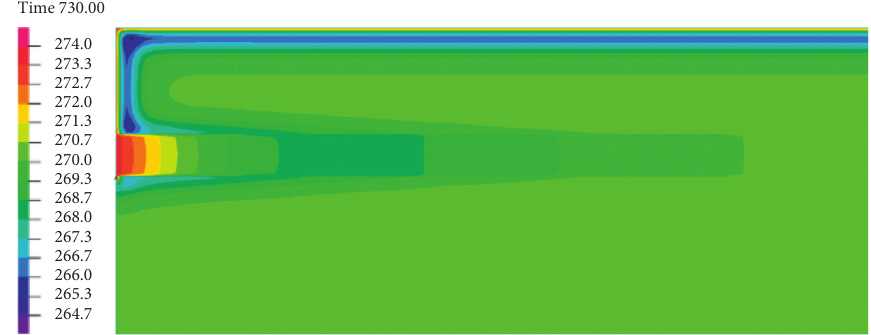
Figure 12: Average temperature distribution inside a tunnel with a 300m length.